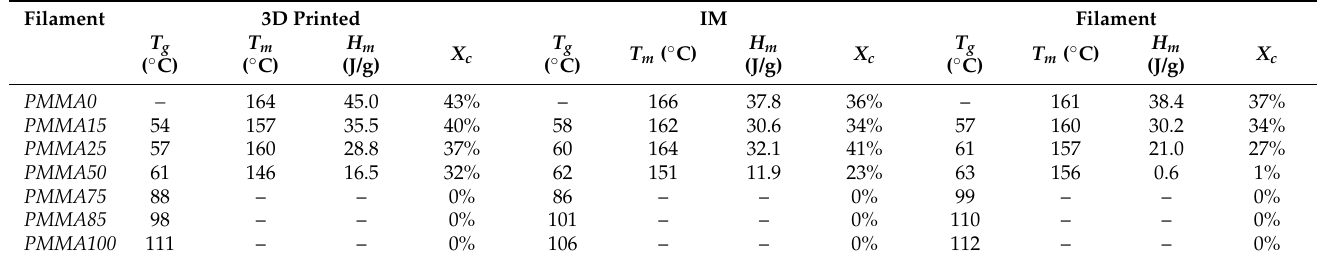
Table 2. Glass transition (T g ), melting temperature (T m ), melting enthalpy (H m ), and crystallization (X c ) for the first DSC heating cycle. Note: –indicates no measured